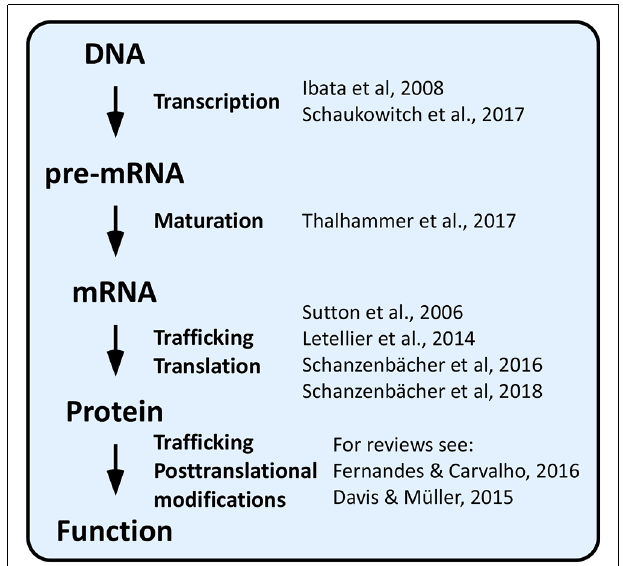
FIGURE 1 | Genes to function in homeostatic